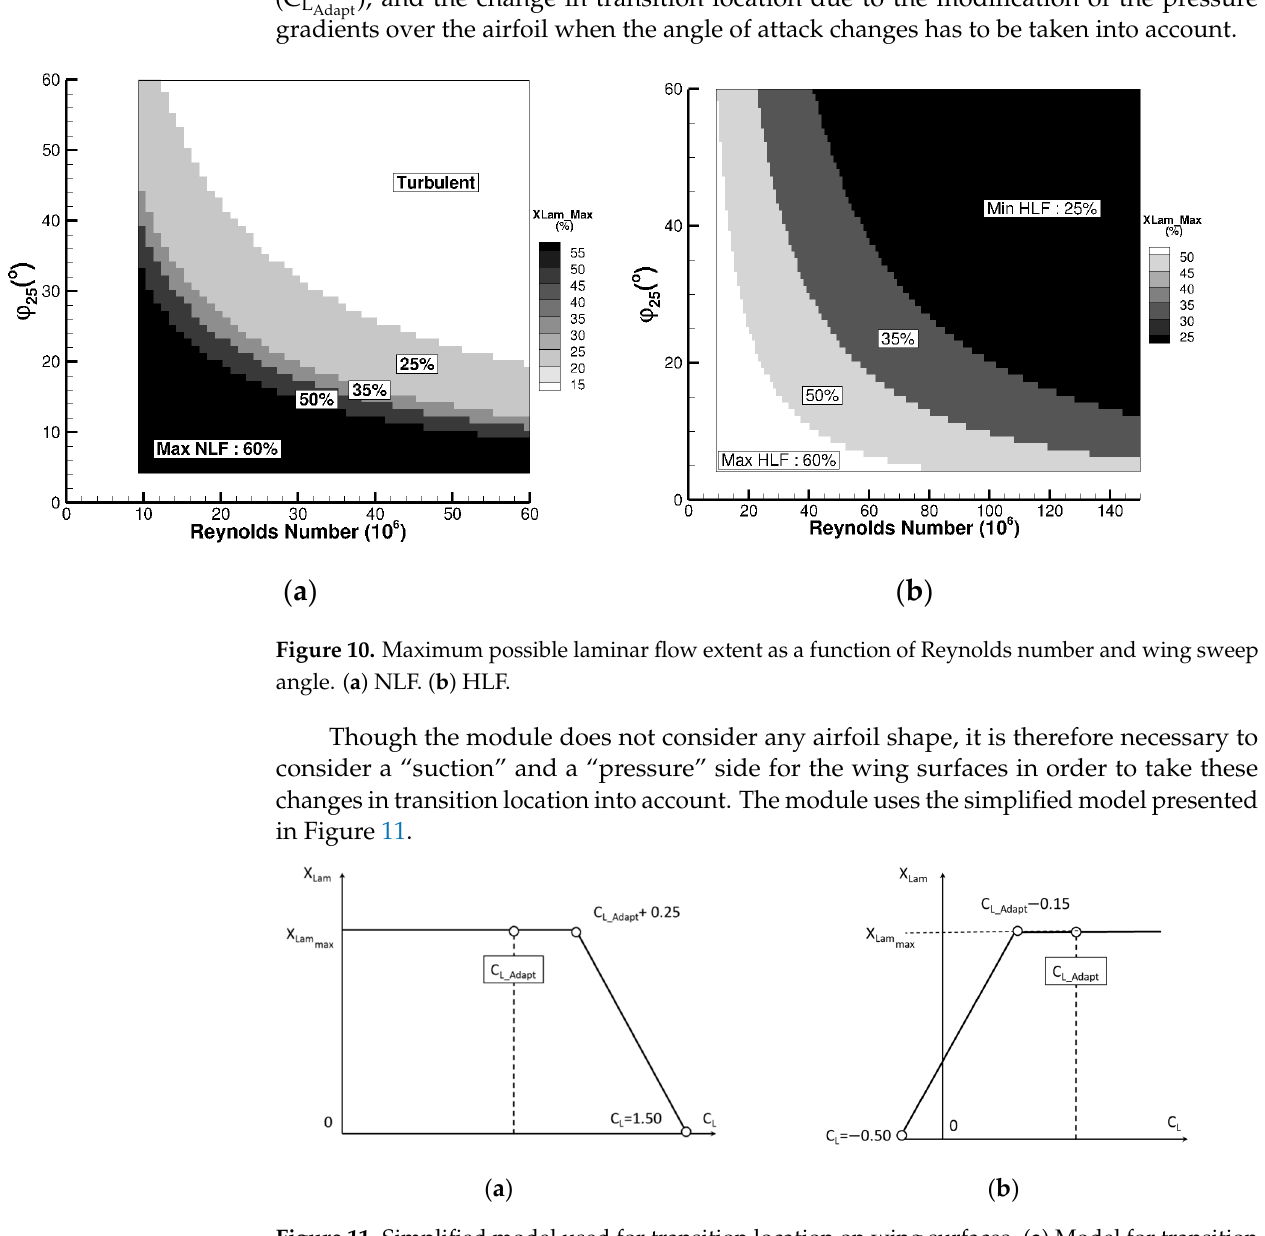
Figure 11. Simplified model used for transition location on wing surfaces. ( a ) Model for transition change on wing suction side. ( b ) Model for transition change on wing pressure side.